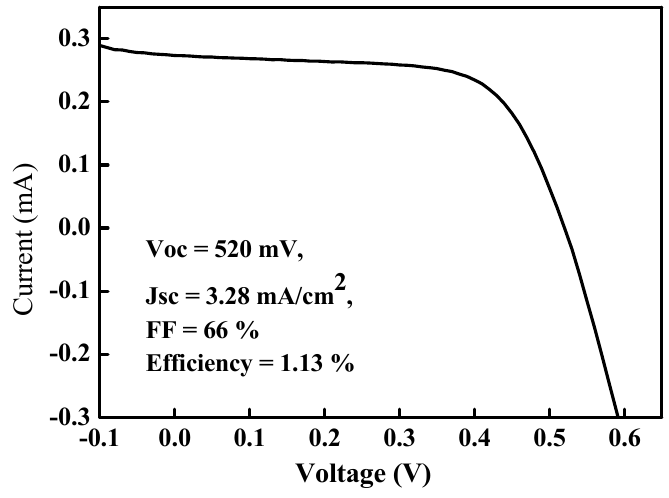
Figure 7. Current-voltage ( I – V ) characteristics of a Mo/CZTS/Si/Al heterostructured solar cell under (air mass) AM 1.5 G.